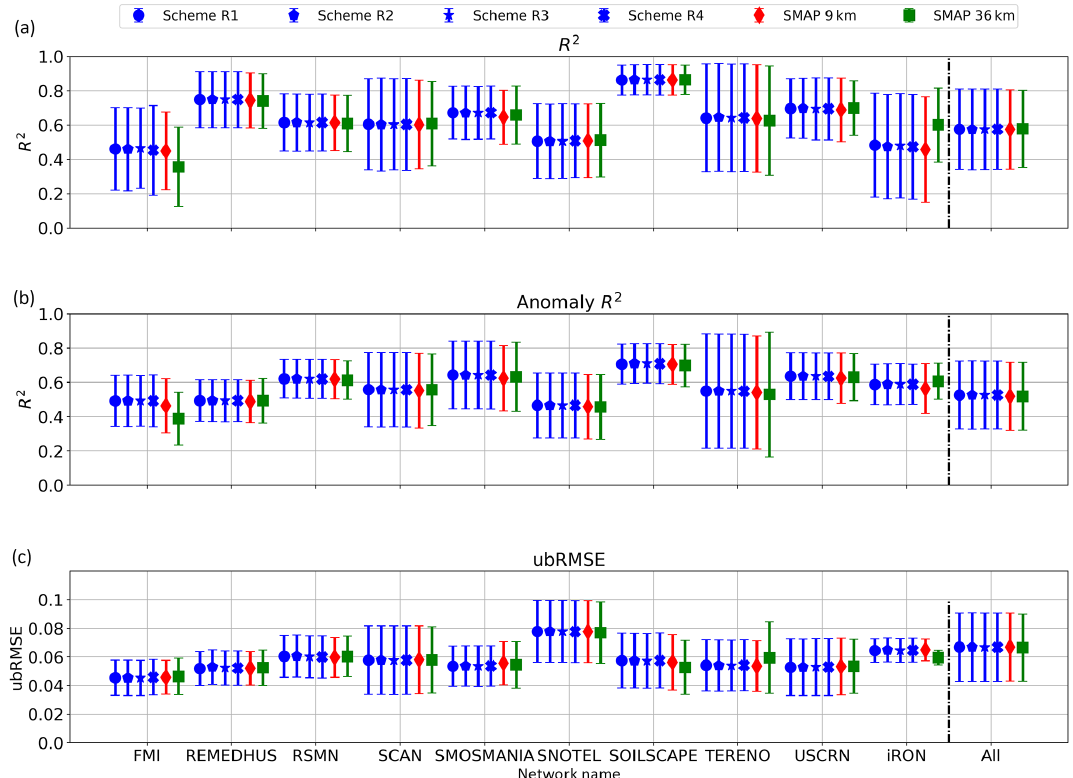
Figure 9. R 2 (a) , anomaly R 2 (b) and ubRMSE (c) of each of the downscaling schemes and SMAP 9km and 36km products across 10 different networks of ISMN. Error bars show 1 standard deviation of each metric around the mean value. Average values across all sites are presented on the right of each